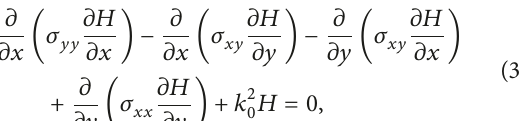
∞ of the metamaterial half-space.